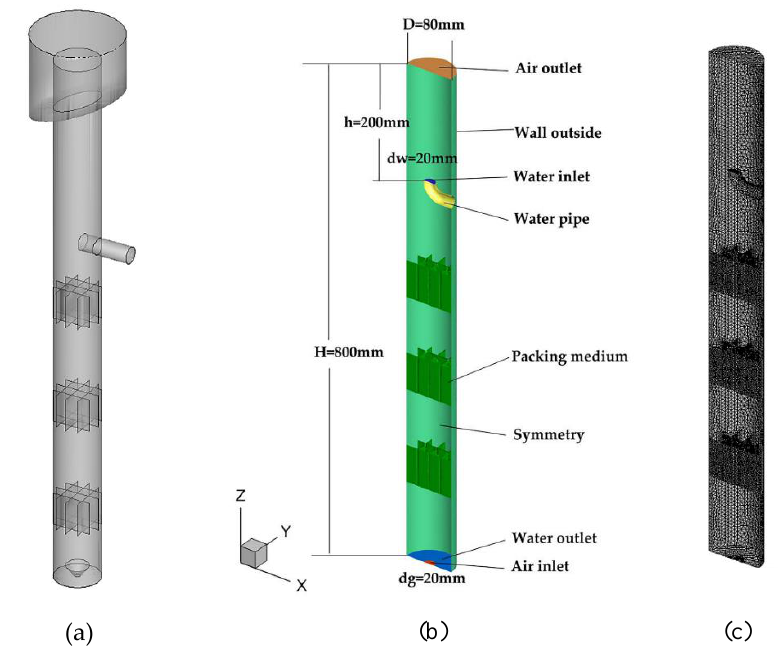
Figure 4. Simulation model and mesh of the flotation column: ( a ) Schematic diagram; ( b ) Geometry; ( c ) Mesh.